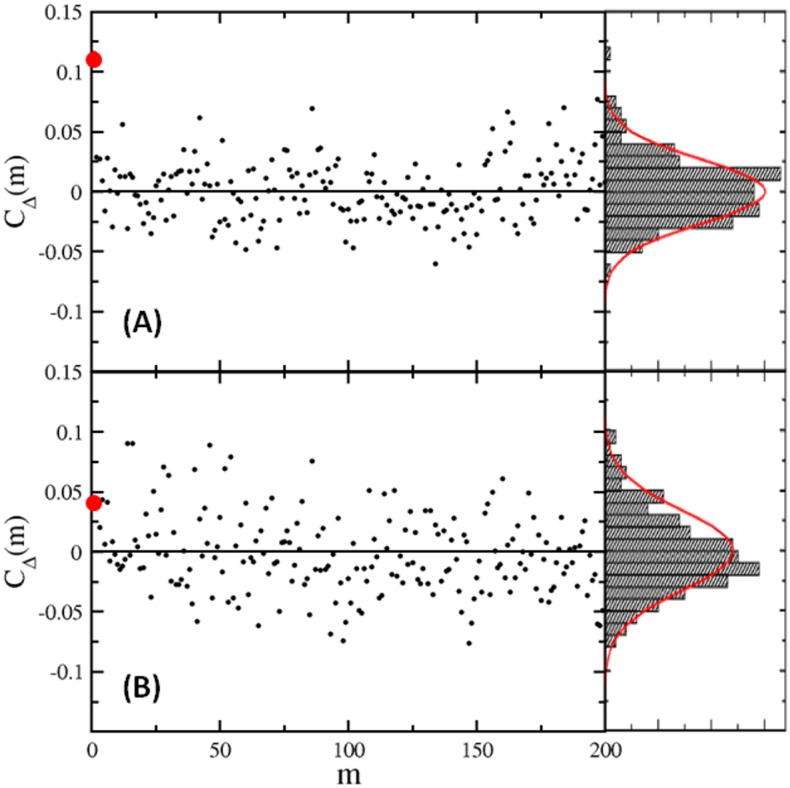
Dwell-time correlations C
Δ(m) for cells #4 (A) and #5 (B).
C
Δ(m) vs. m are plotted on the left panels and the PDFs of C
Δ(m) are plotted on the right panels. The big red dots denote C
Δ(1). The red curves depict normal distributions centered at zero.